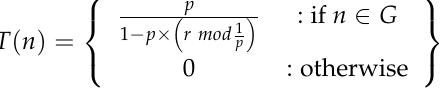
Figure 3. Processes of the setup phase.